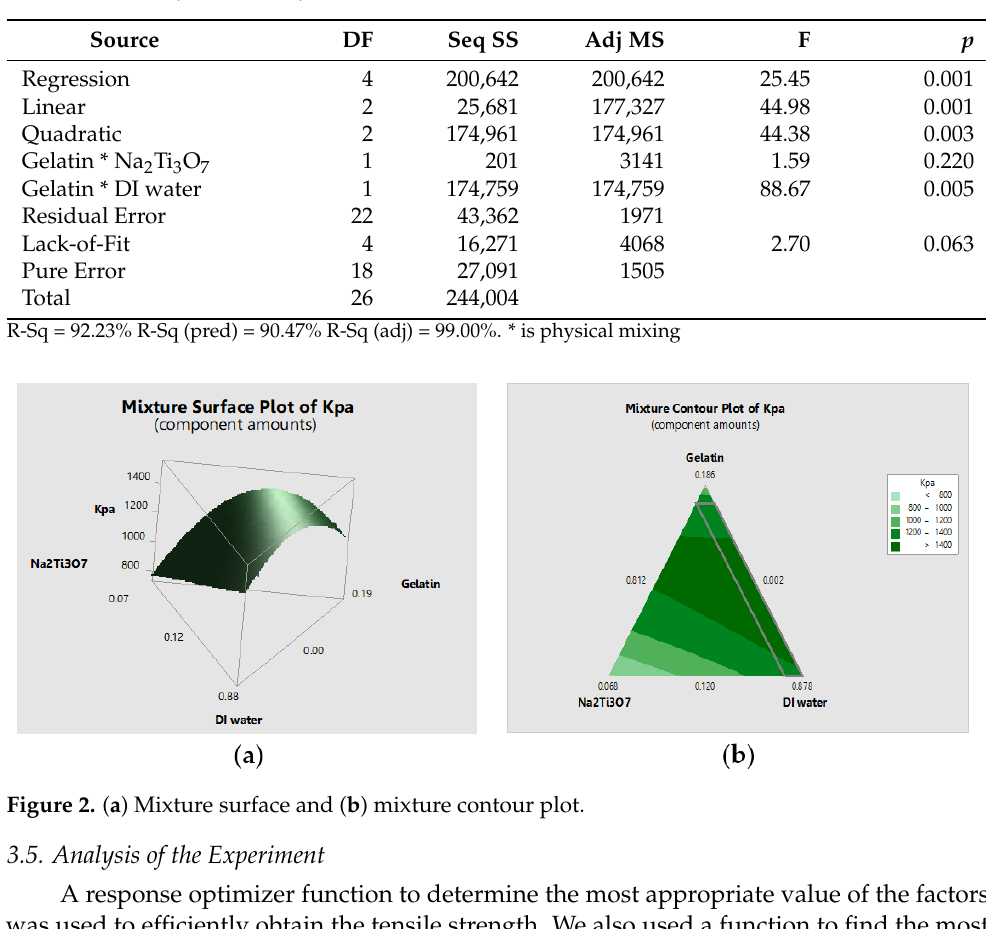
Table 3. Summary of the analysis of variance (ANOVA).